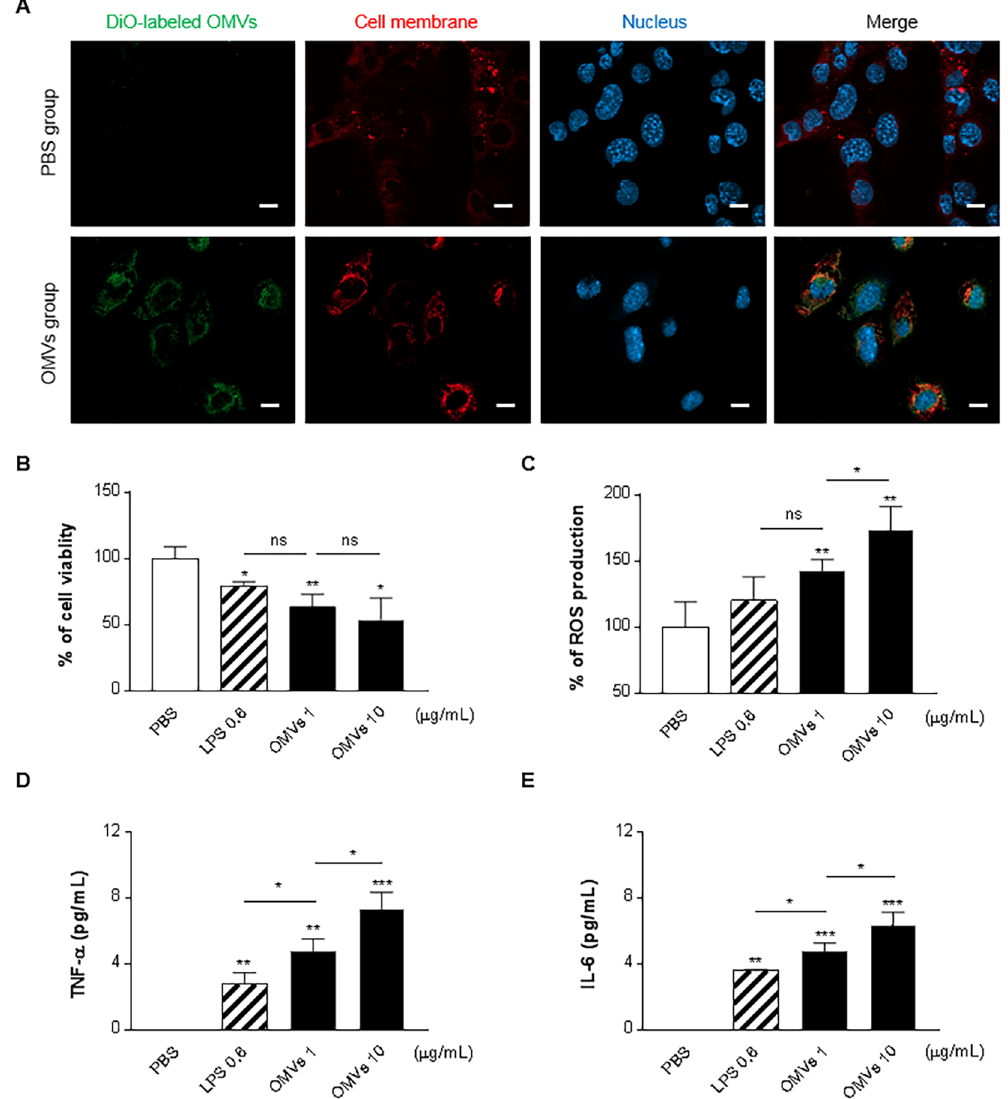
Figure 2. OMVs in HL-1 induce cytotoxicity and pro-inflammatory cytokine production. ( A ) OMVs (10 μ g/ mL) were incubated with cells for 6 h. OMVs, cell membrane, and nuclei were stained by DiO (Green), Cellmask Deep Red (Red), and DAPI, respectively. Scale bars, 20 µ m. ( B ) Cells were exposed to LPS (0.6 µ g/mL) or OMVs (1, 10 µ g/mL) for 48 h and cell viability was assessed by MTT assay. Results are expressed in percentage of control. ( C ) Cell were treated with the peroxide-sensitive florescent probe 2 ′ ,7 ′ -dichlorofluorescein di-acetate, followed by incubation with LPS (0.6 µ g/mL) or OMVs (1, 10 µ g/mL) for 3 h. Fluorescence was read at 560 nm, and ROS generation was expressed as percent change compared to the untreated control. ( D and E ) LPS (0.6 µ g/ mL) or OMVs (1, 10 µ g/mL) were added to the cells, and the culture supernatant concentrations of TNF- α and IL-6 24 h later are shown in panel D and E , respectively. * P < 0.05; ** P < 0.01; ** * P < 0.001; ns, not significant; versus PBS group. LPS (0.6 µ g/mL) and OMVs (10 µ g/mL) group were also compared with OMVs (1 µ g/mL) group. Error bars indicate SEM. n =